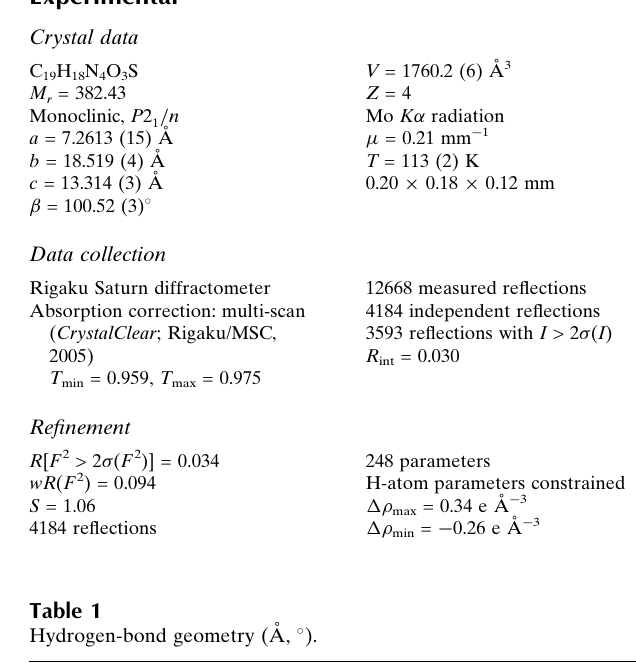
Rigaku Saturn diffractometer Absorption correction: multi-scan